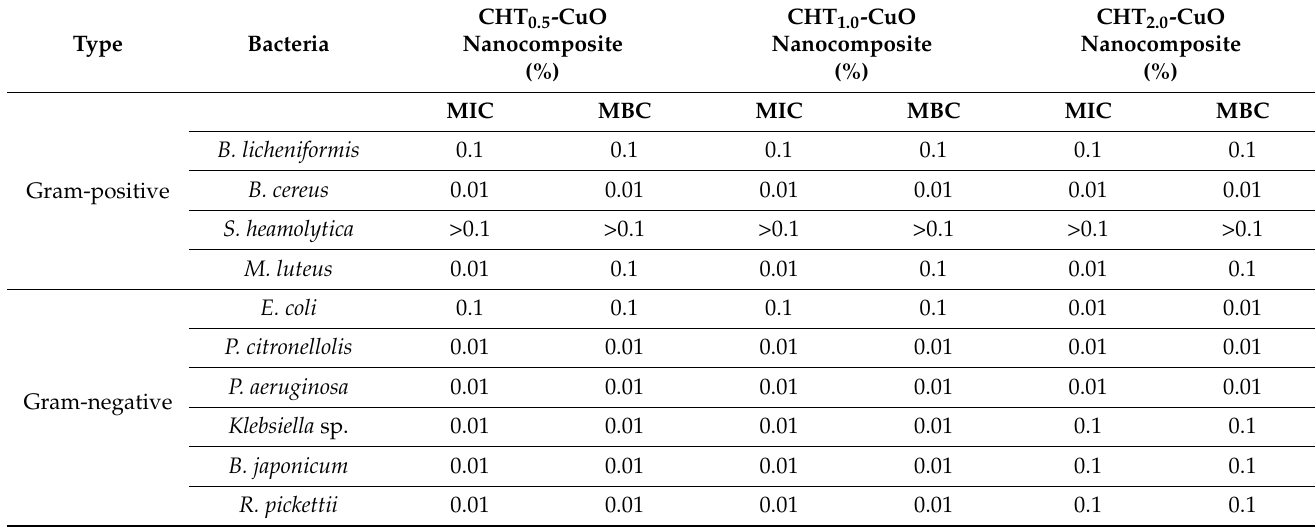
Table 1. Minimum inhibitory concentration that inhibits bacteria growth based on visual turbidity or bacteriostatic effect (MIC, in %) and minimum inhibitory concentration that inhibit growth in solid plate culture or bactericidal effect (MBC, in %). For CHT-CuO